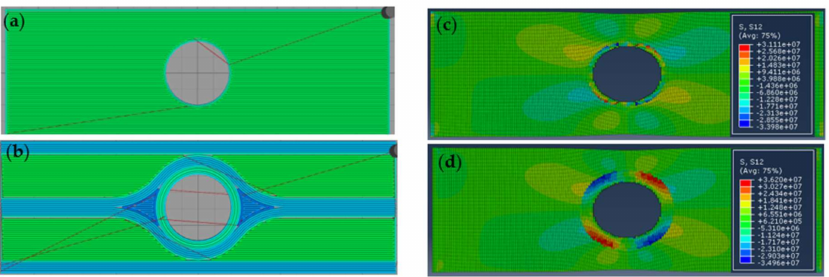
Figure 21. ( a ) 0 ◦ uniform; ( b ) customized tool-path; ( c ) shear strain distribution of samples printed by 0 ◦ uniform; ( d ) customized